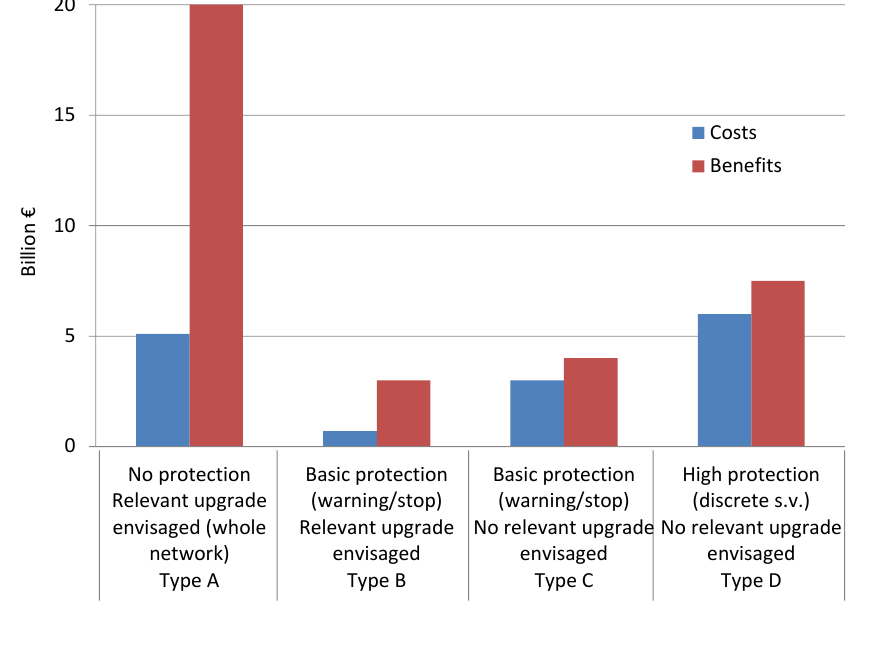
Figure 1. Comparison of costs and benefits (billion of e ) of the project for the European regional network (selected countries) by Type of context (Data from